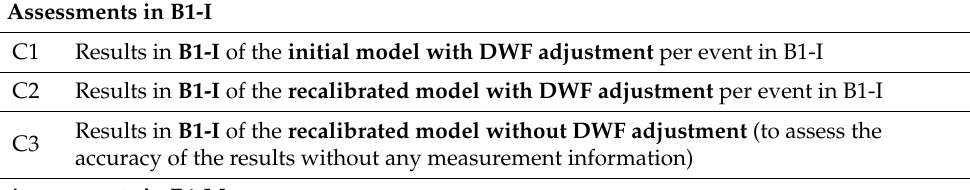
Table 3. Assessments carried